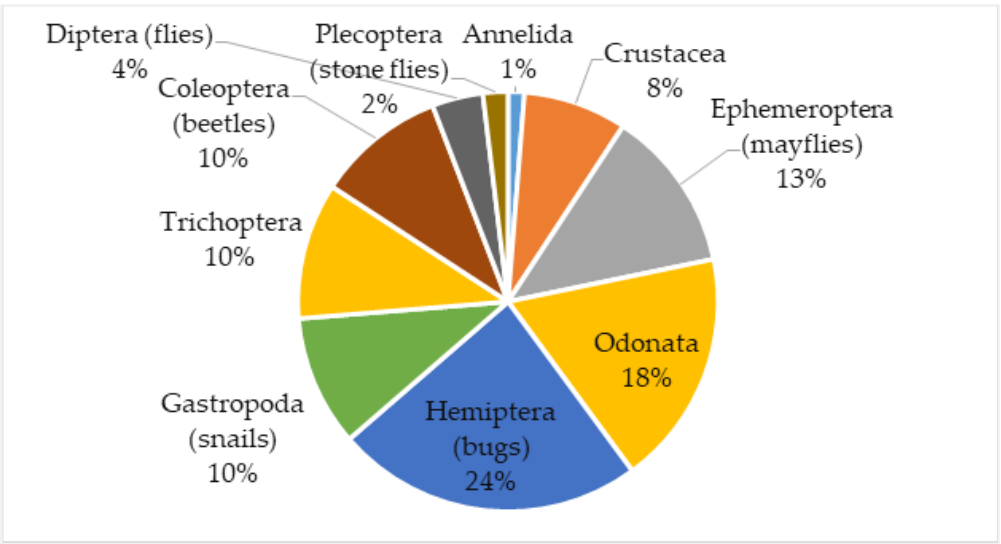
Figure 4. Distribution of macroinvertebrate taxa in five investigated streams used in irrigation systems in Kilombero Valley, Tanzania.